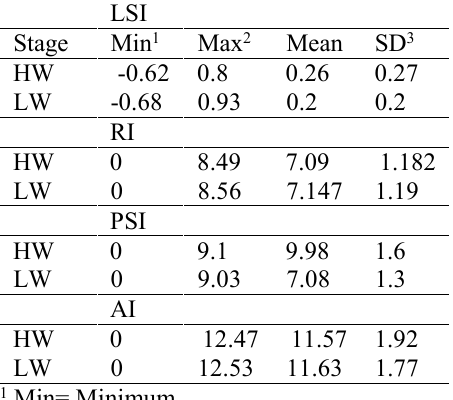
Table 3. Calculated corrosion and scaling index for water supplies in rural areas of Sarvabad